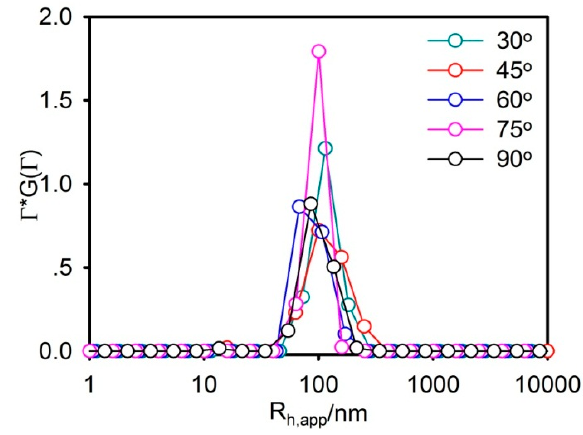
Figure 3. Size distribution of DS-lipo in serum at 24 h. ρ p/l = 1.0. Temperature = 37 °C.